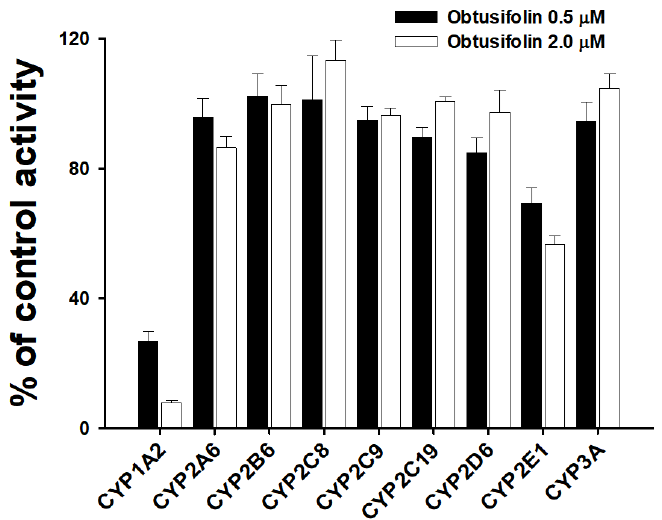
Figure 6. Inhibitory effects of obtusifolin [0.5 ( ■ ) and 2.0 μM (□)] on enzyme activities of nine P450 isoforms in human liver microsomes (0.25 mg/mL). The data are depicted as the average obtained from triplicate experiments ( n = 3).